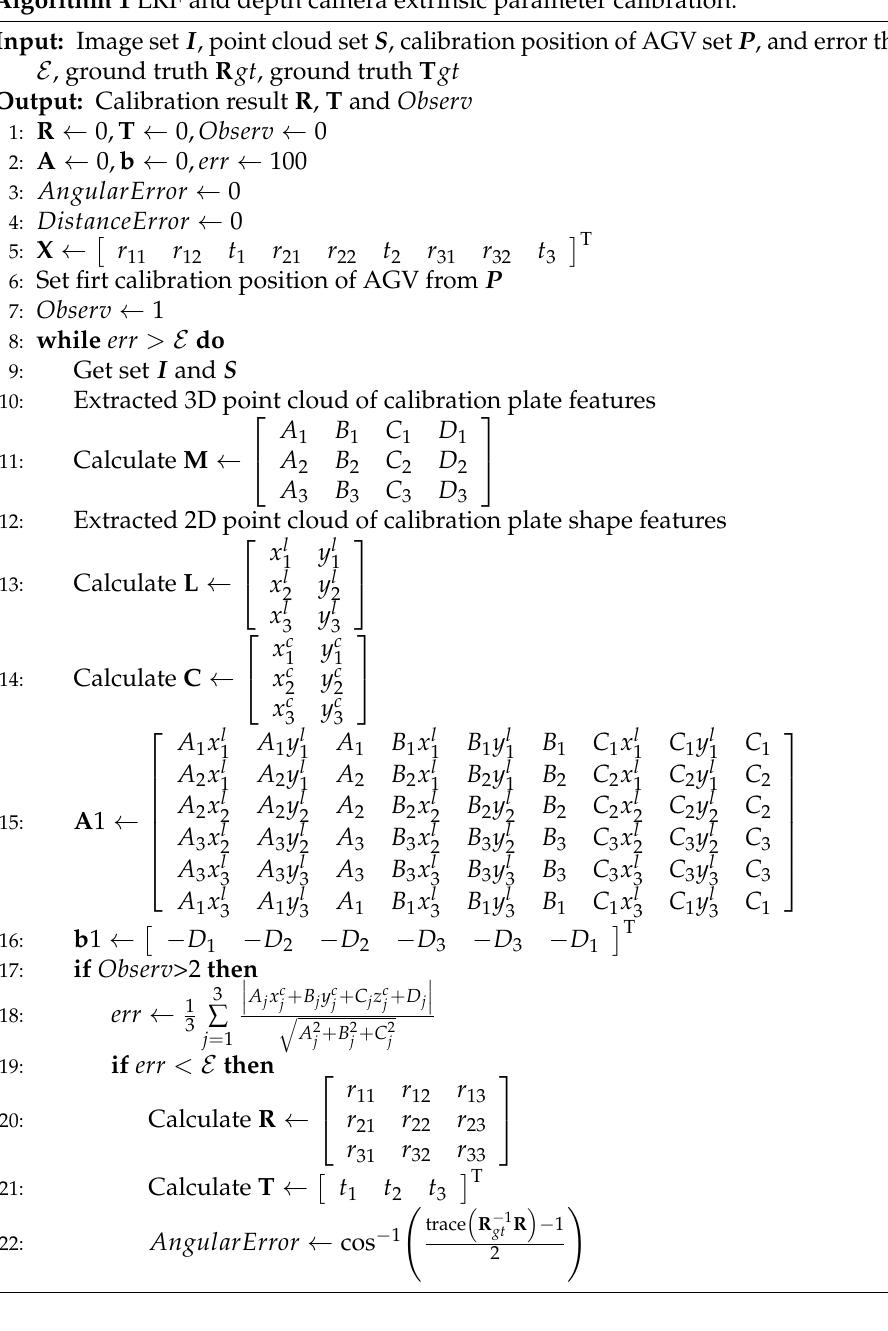
Algorithm 1 LRF and depth camera extrinsic parameter